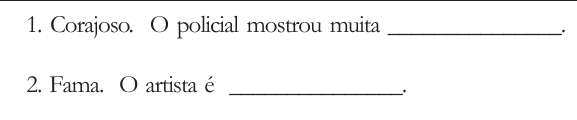
Figura 2. Exemplo de itens do teste de estrutura morfológica.